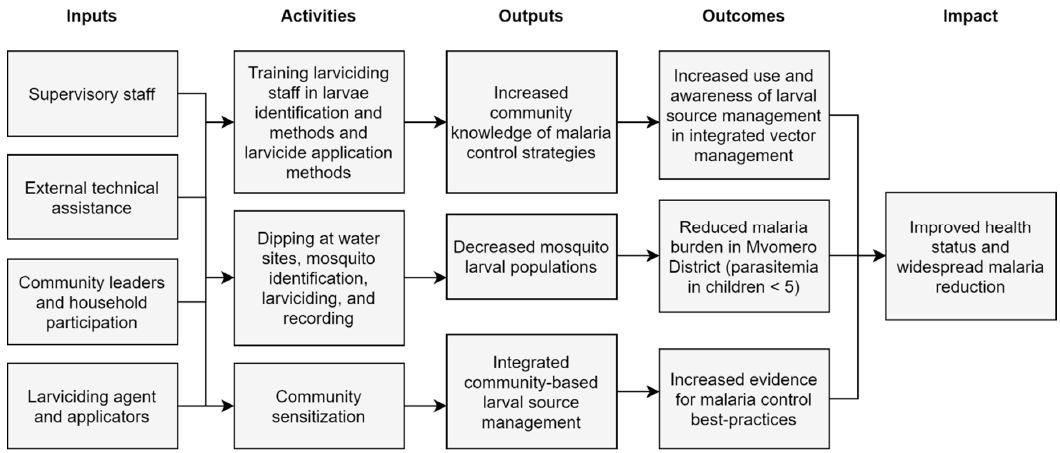
Figure 3. Logic model for the malarial larviciding component of the Mvomero Project intervention. Table 1. Indicators and analysis